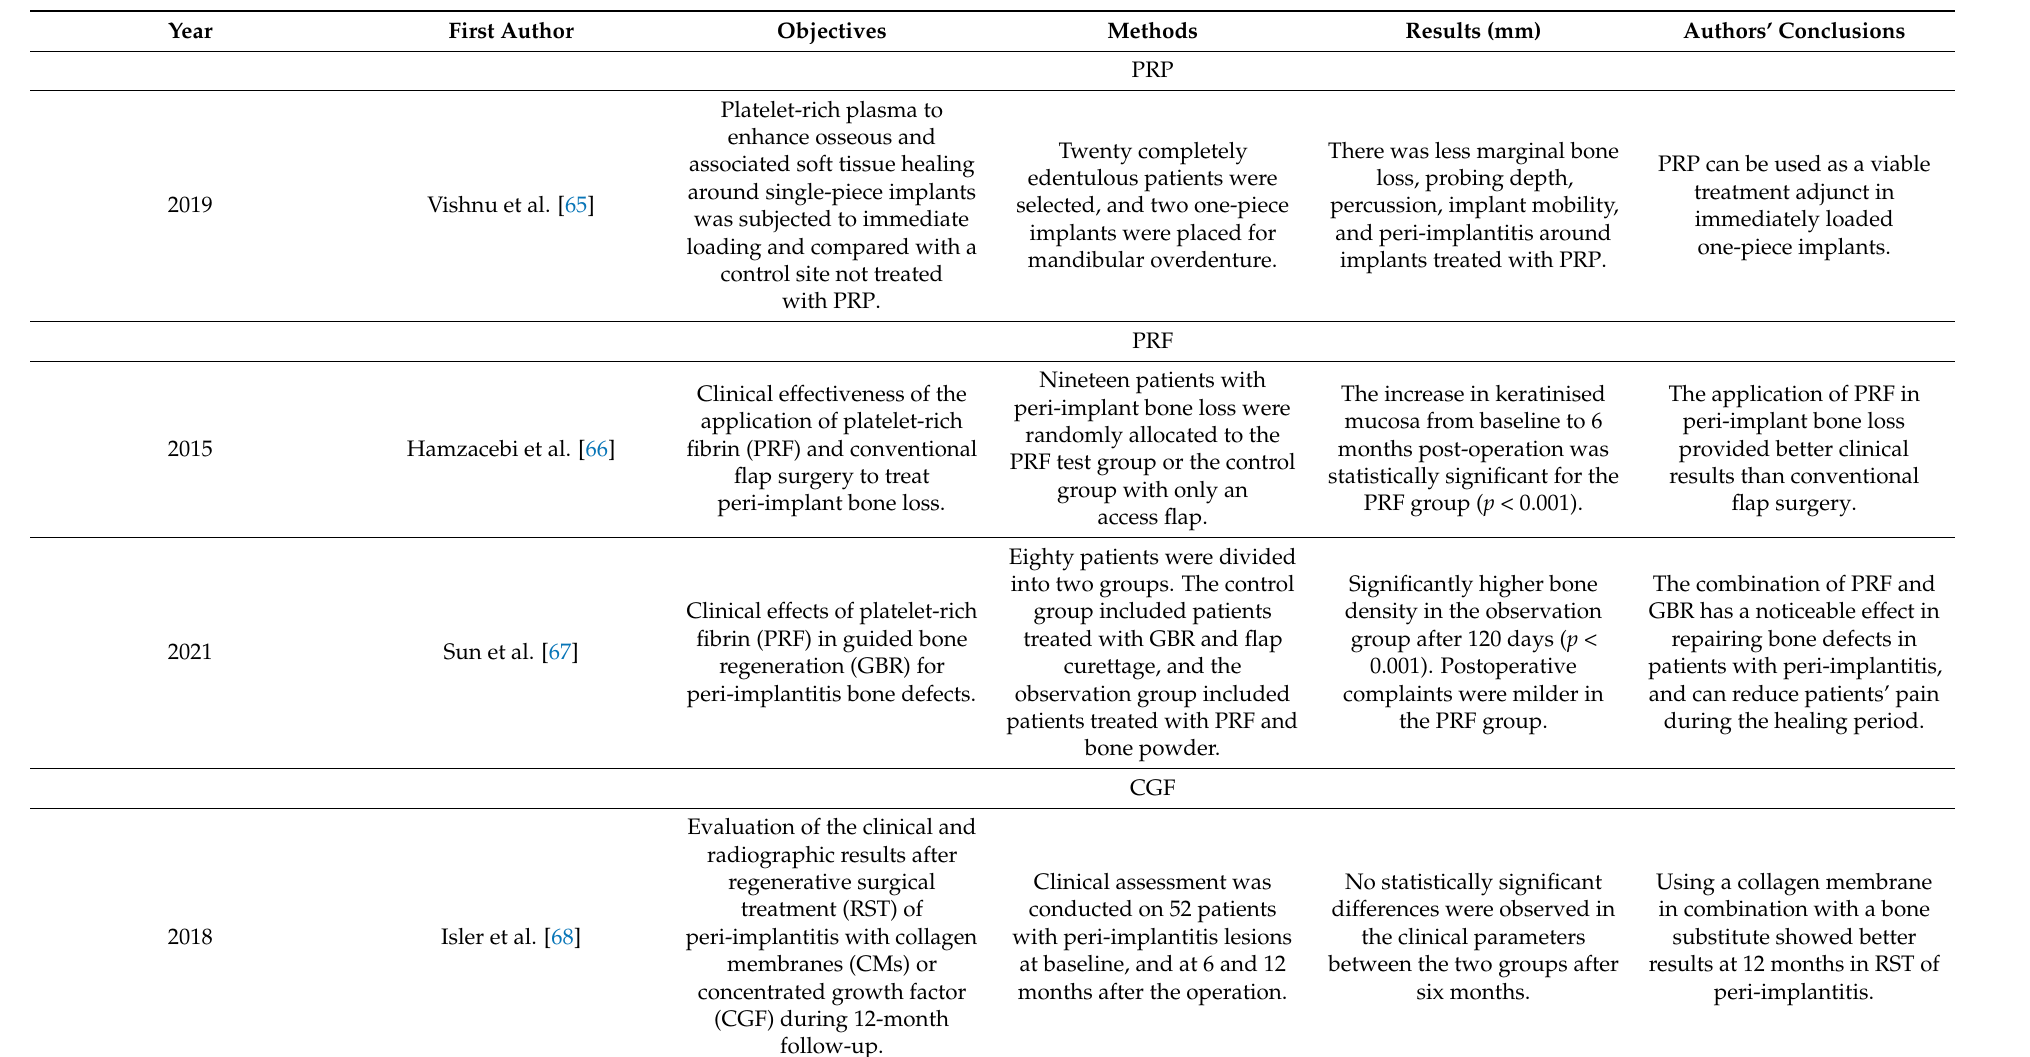
Table 4. Comparison between the 3 APC techniques (PRP, PRF, and CGF) in